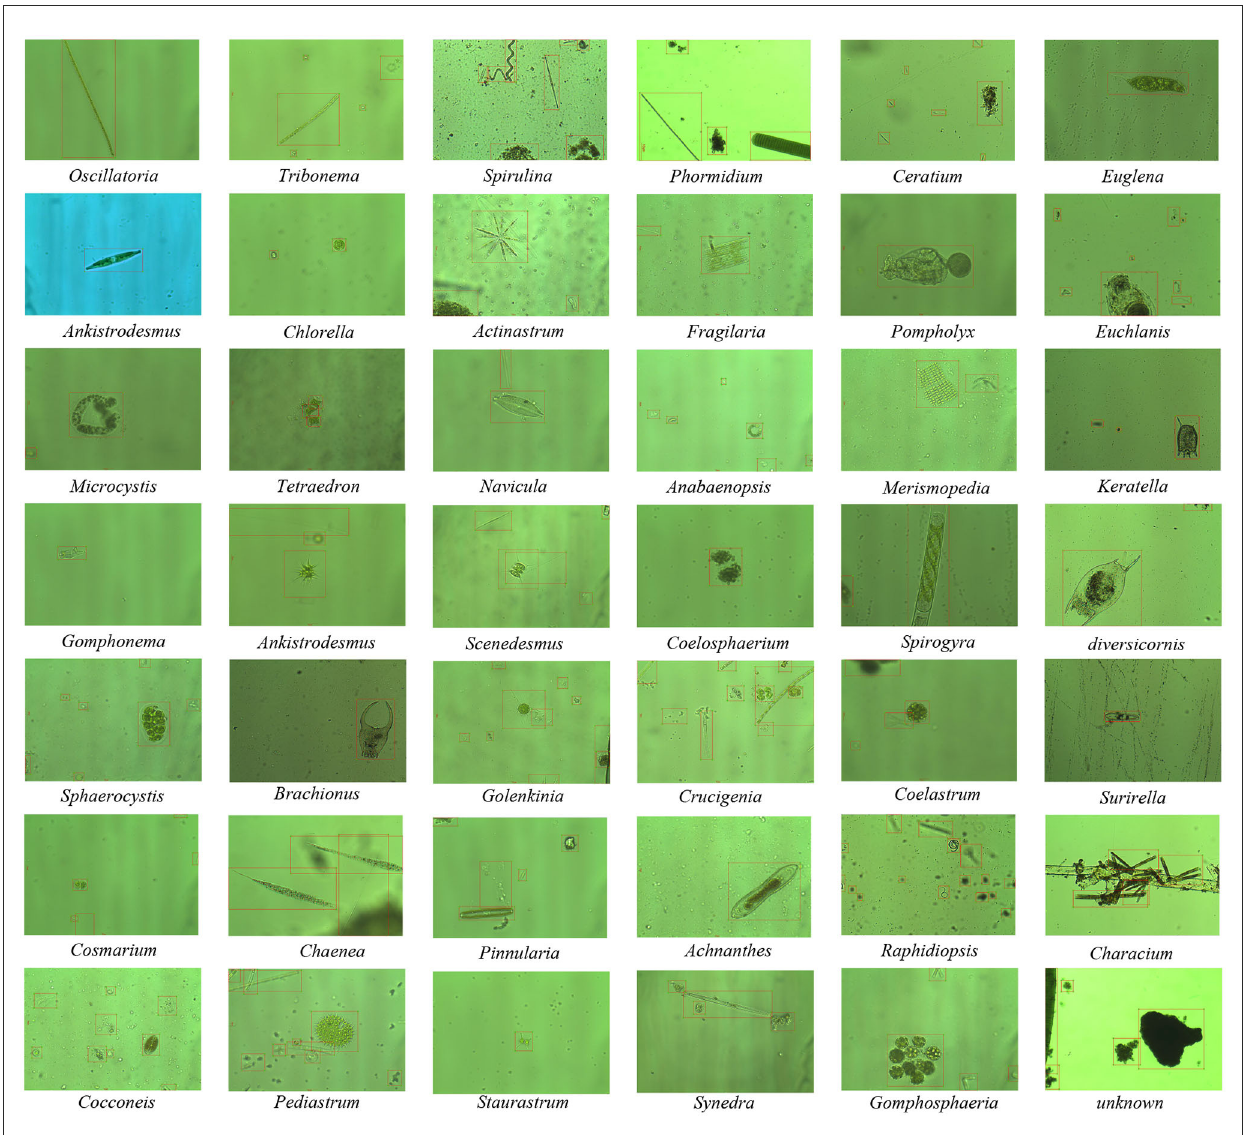
FIGURE2 An example of EM images in EMDS-7 (The red boxes are labeled EM